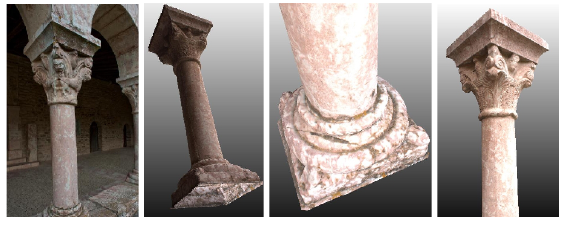
Figure 1: Image-based 3D reconstruction of a column with its decorated capital and